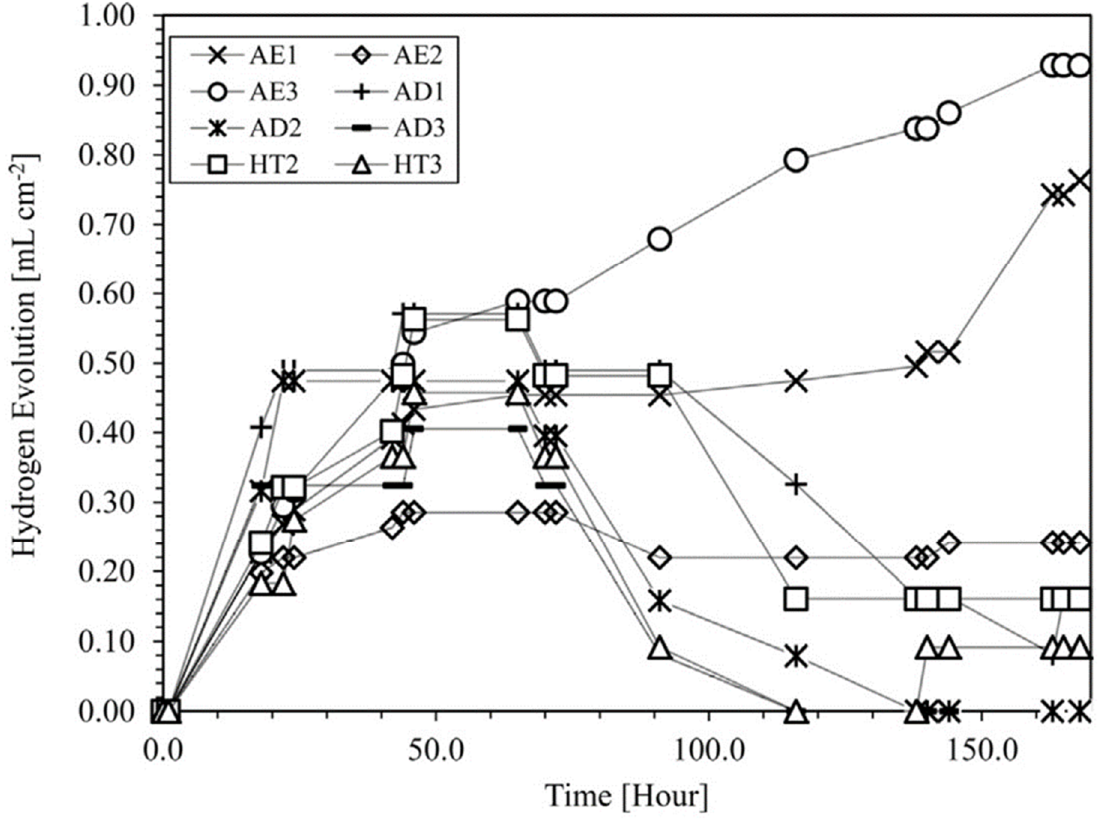
Figure 3. Hydrogen evolution [82] for various Mg alloys in Nor’s solution: CO 2 -bicarbonate buffered Hanks’ solution.